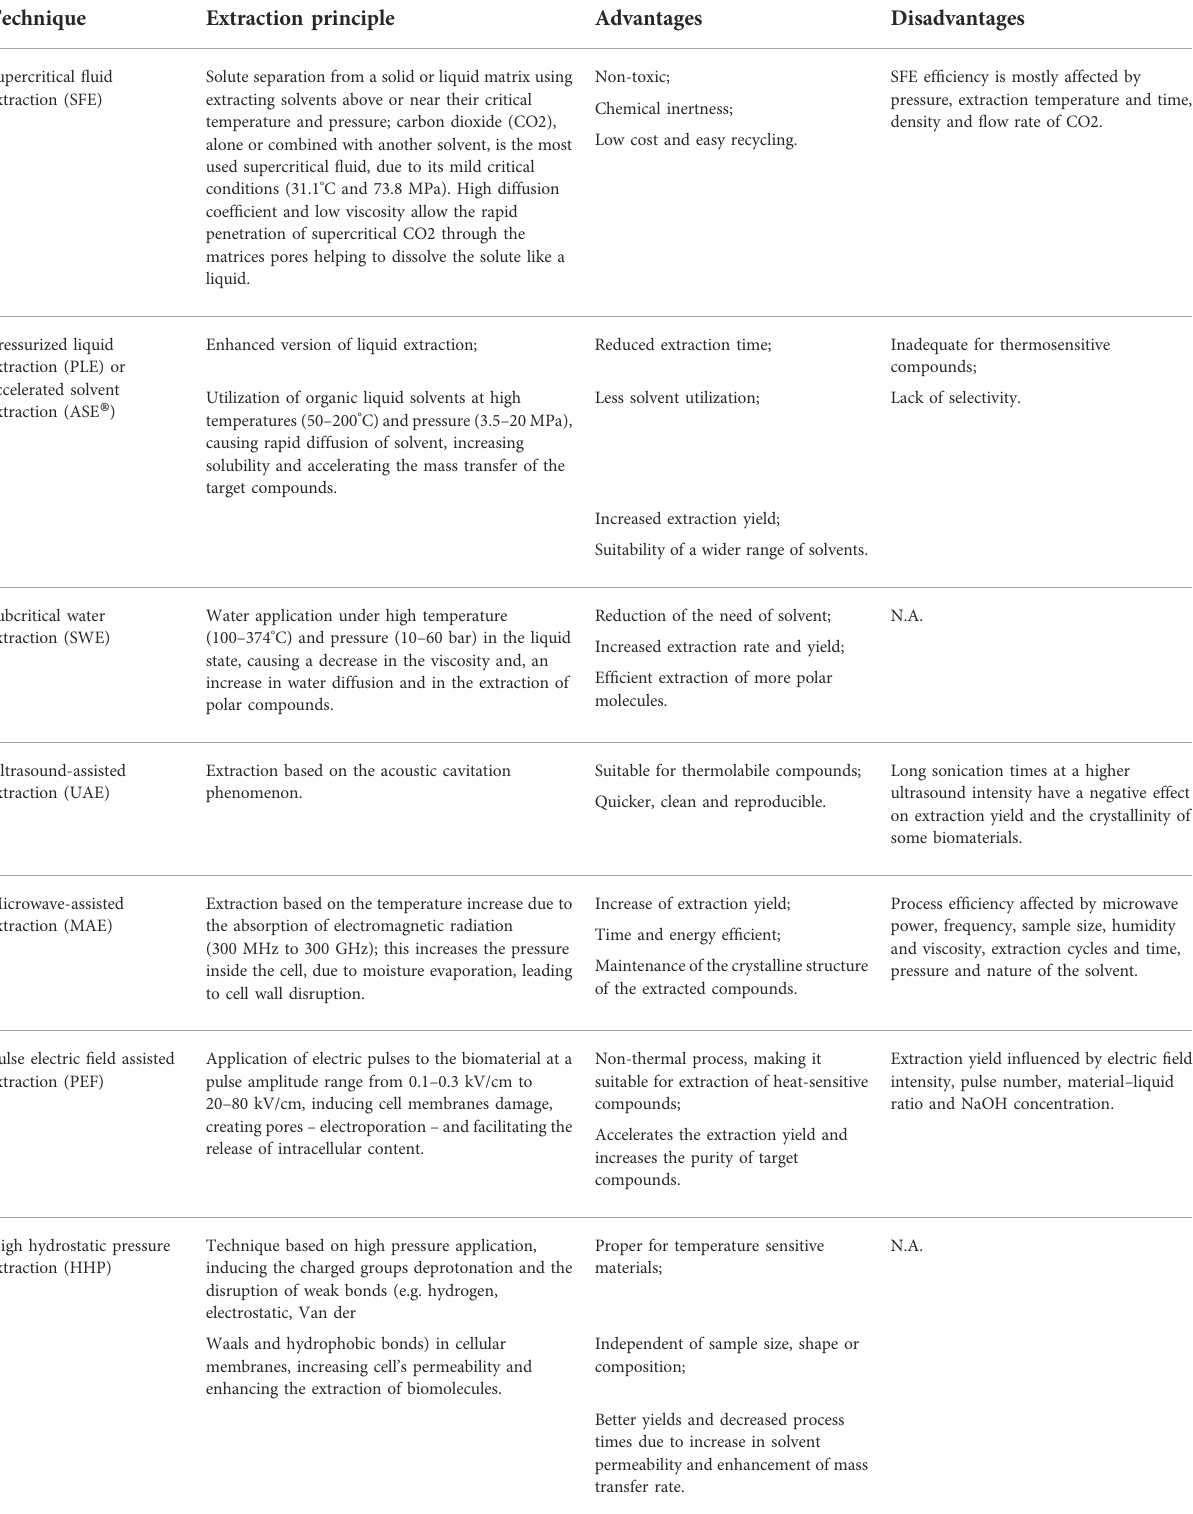
TABLE 1 Main features of Green Extraction Techniques summarized from (Bruno et al., 2019).